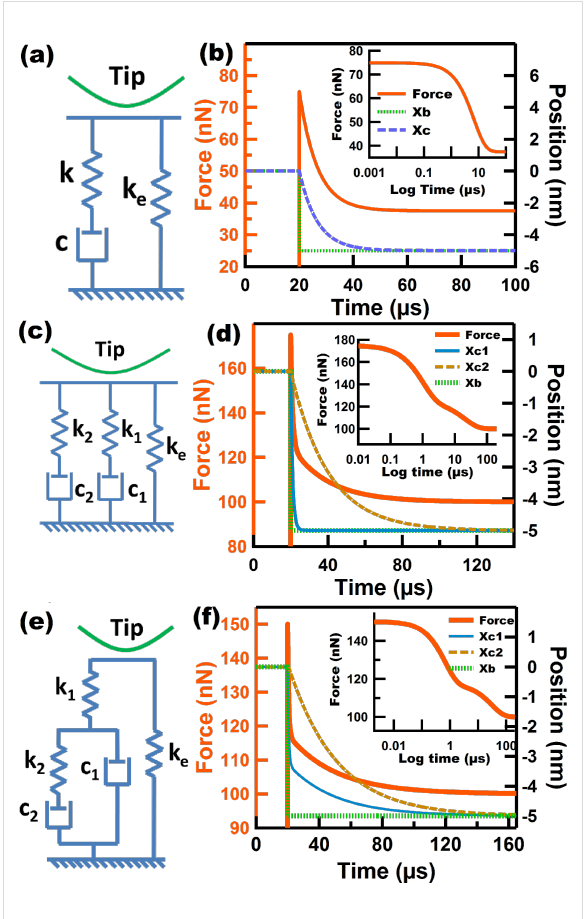
Figure 3: (a), (c), and (e) Standard linear solid (SLS) model, Wiechert model, and Nafion model, respectively; (b), (d), and (f) stress relax- ation simulations for SLS, Wiechert, and Nafion models, respectively. The insets show the stress relaxation experiments for which time is plotted in logarithmic scale to show the inflection points corresponding to the relaxation times. The parameters for (b) are: k e = k = 7.5 N/m, c = 5.0 × 10 − 5 N·s/m. The parameters for (d) and (f) are: k e = 20 N/m,